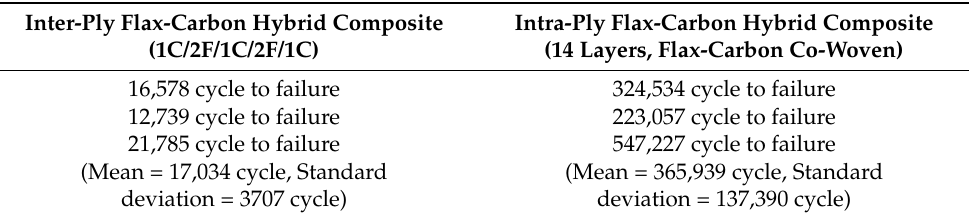
Table 3. Fatigue test results for inter-ply and intra-ply flax-carbon hybrid composites (three sample for each type).